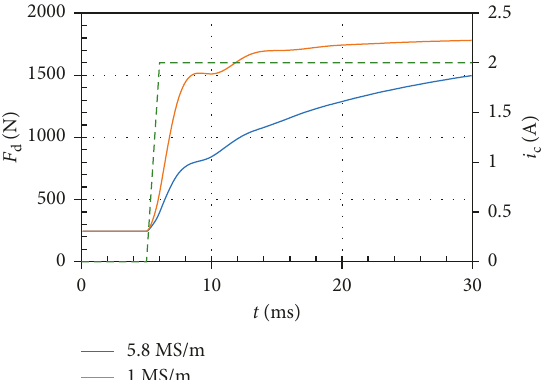
Figure 29: Core material’s electric conductivity: Full line: damping force time history; green dashed line: current step input. H � 0 . V r